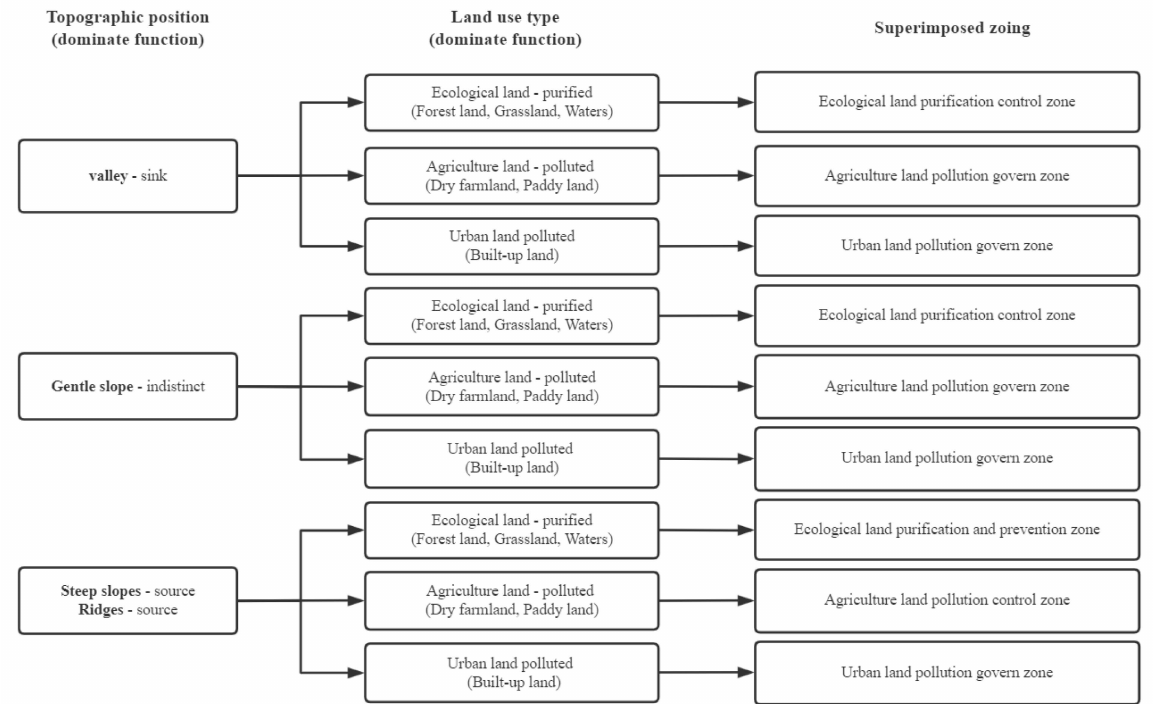
Figure 20. Principles of superimposed